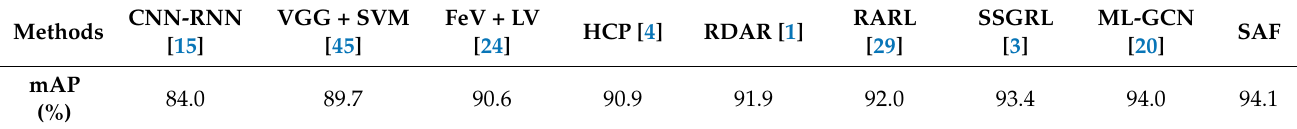
Table 3. Classification results of different methods on VOC2007.